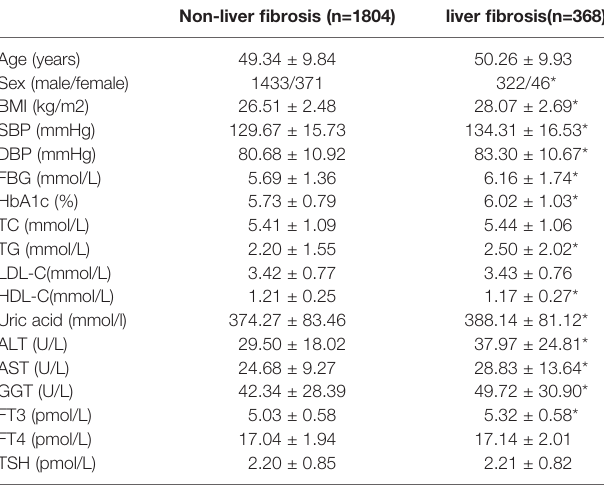
TABLE 2 | Baseline characteristics of individuals with or without liver fi brosis in NAFLD.